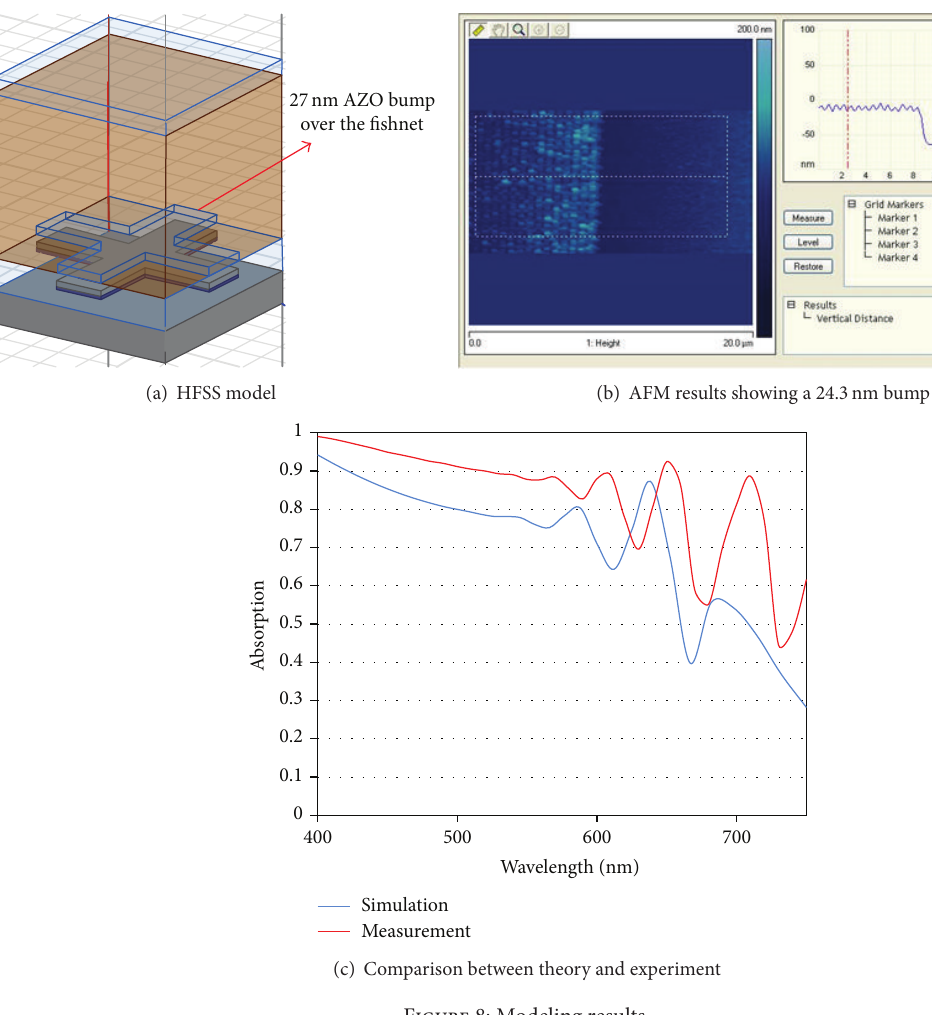
Figure 8: Modeling